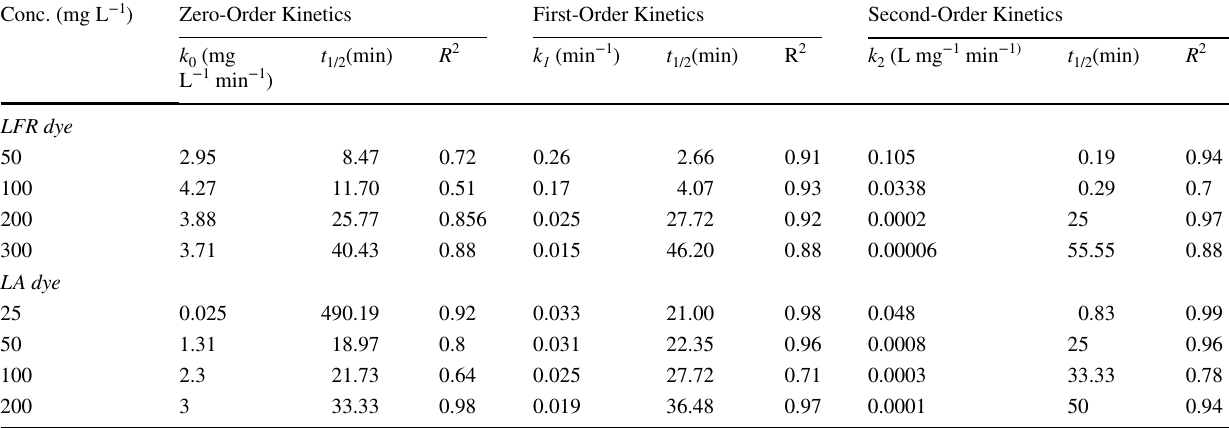
Table 2 Parameters of Zero-, First- and Second-kinetic models for LFR and LA by AS-Fenton Conc. (mg L −1 )